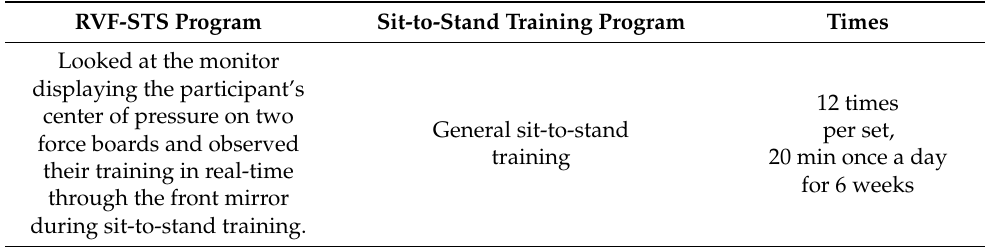
Table 1. Sit-to-stand training